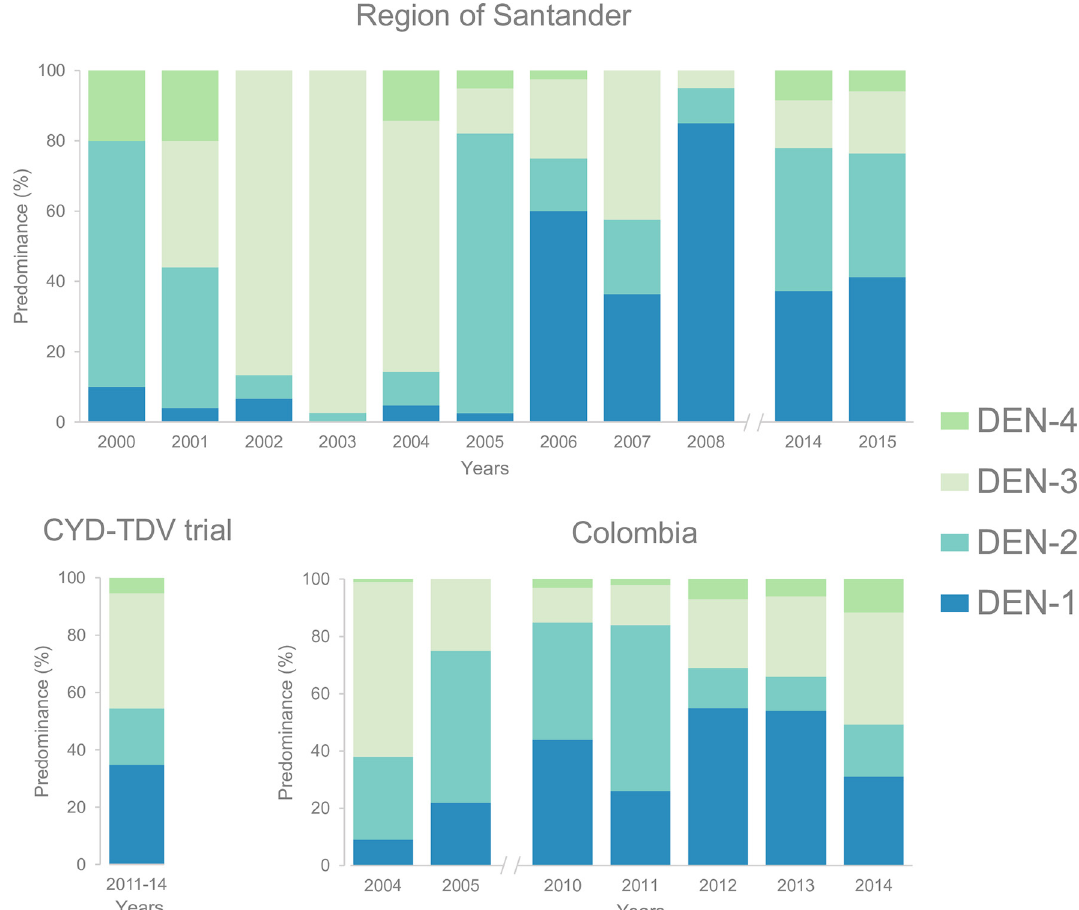
Fig 1. Relative predominance of dengue serotypes in Colombia. Santander data correspond to aggregated observations in the metropolitan area of Bucaramanga (State of Santander) and the province of Oca ñ a (State of Norte de Santander) reported by the Grupo de Investigación y Enfermedades Tropicales (CINTROP) from Industrial University of Santander (UIS) [8 – 11]. The CYD-TDV data correspond to the country-specific infecting serotype of virologically confirmed dengue in the intention-to-treat group [3]. Data for the whole country come from the National Institute of Health